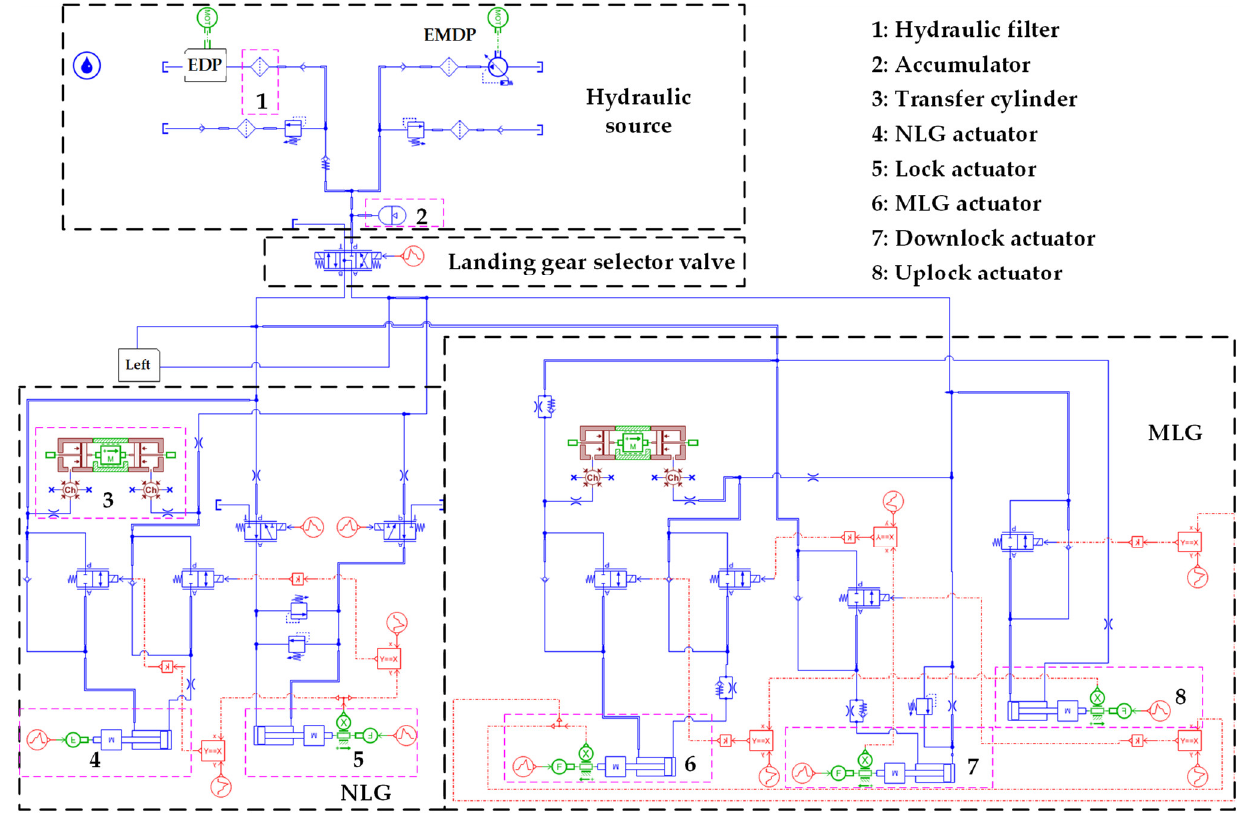
Figure 4. Overall simulation model of landing gear hydraulic extension and retraction sys- tem.